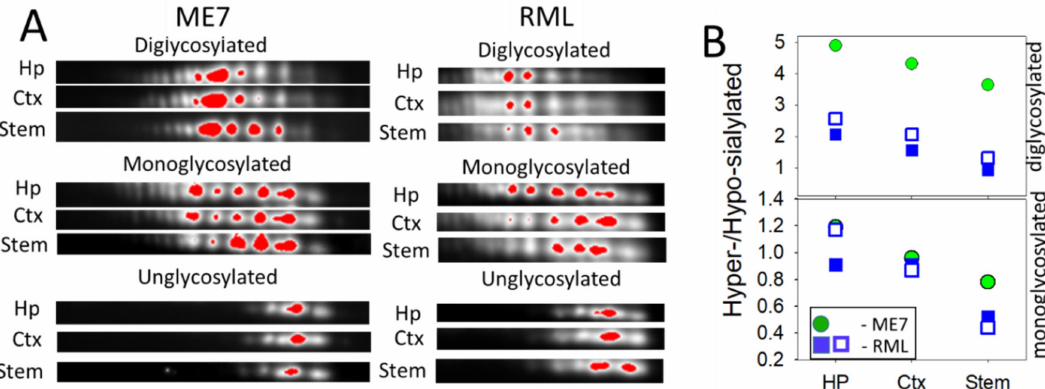
Figure 4. Analysis of sialylation status of PrP Sc from ME7- and RML-infected animals. ( A ) 2D Western blot analysis of charge distribution of PrP Sc sialoglycoforms from hippocampus (Hp), cortex (Ctx), and stem. Prior to 2D blot, brain materials were treated with 20 µ g / ml PK. Intensity of individual sialoglycoforms is visualized by red color using Alpha View software. ( B ) A plot showing the ratio of hypersialylated versus hyposialylated PrP Sc in hippocampus (Hp), cortex (Ctx) and stem in ME7-infected animal (circles, n = 1) and RML-infected animals (squares, n = 2). Diglycosylated and monoglycosylated sialoglycoforms are analyzed separately. The ratio of hypersialylated versus hyposialylated isoforms is calculated as described in Materials and